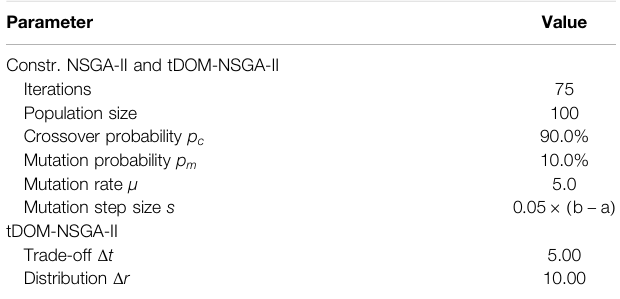
TABLE1| Algorithmparametersettingsusedforthecasestudieswith a and b the lower and upper boundary respectively of the optimisation variables.